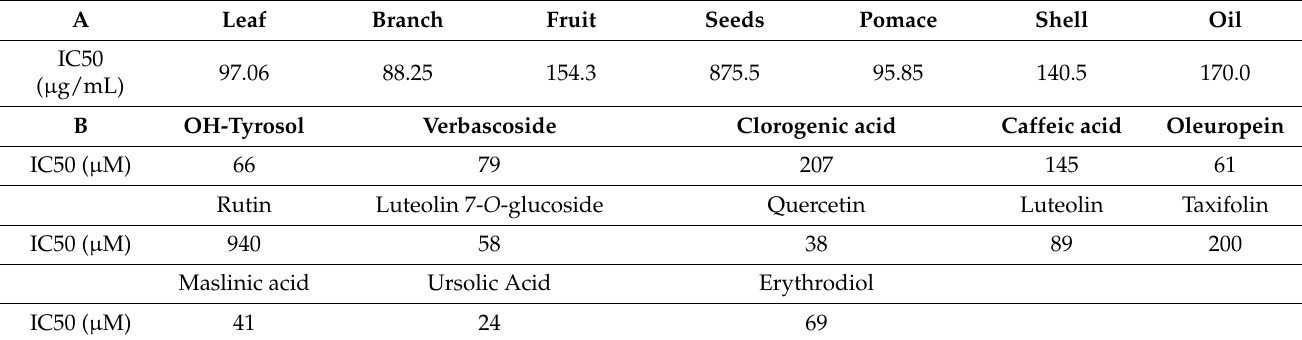
Table 3. ( A ) IC 50 values of the phenolic and triterpenoid extracts from Frantoio cv; ( B ) IC 50 values of some representative pure phenols and